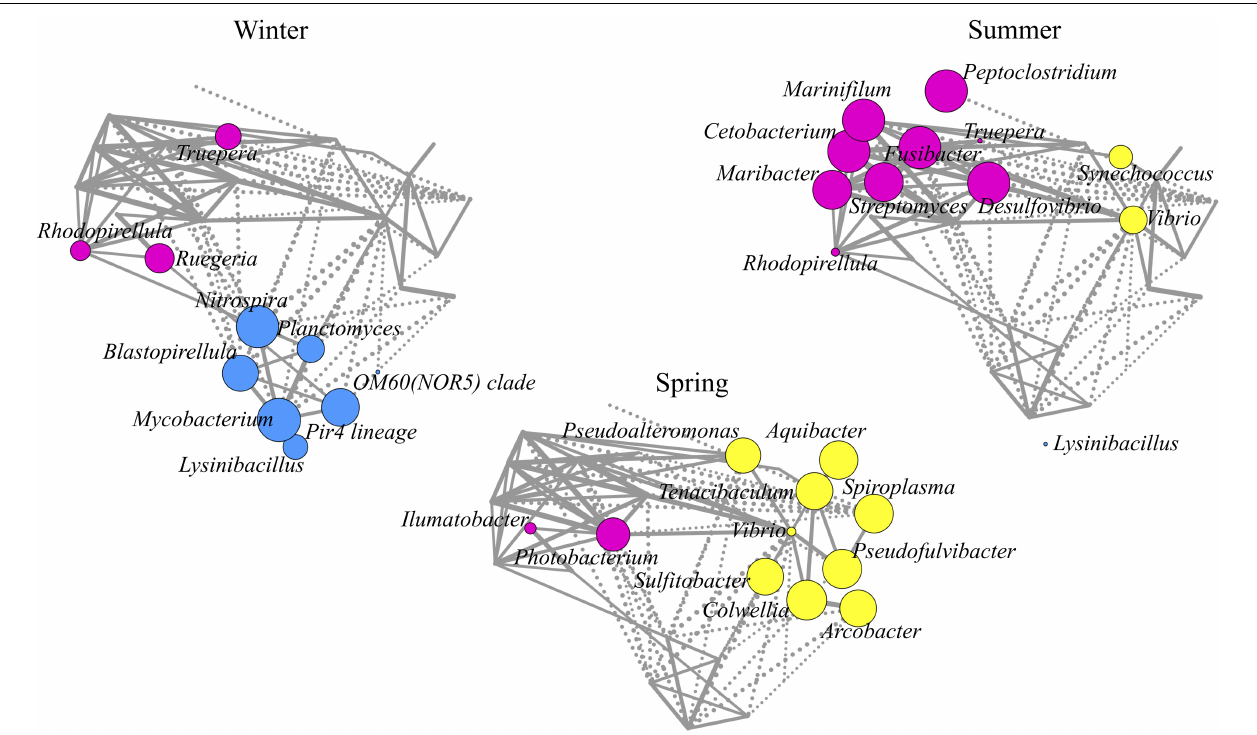
FIGURE 4 | Declination of C. viridis co-abundance groups according to seasonality. Co-abundance groups (CAGs) are named according to the dominant genus in each group: Mycobacterium , Colwellia , and Desulfovibrio . Each node represents a bacterial genus and its size is proportional to its overabundance on the average value within the population. The connections between nodes represent positive (solid lines) and negative (dashed lines) Kendall correlations between genera (FDR ≤